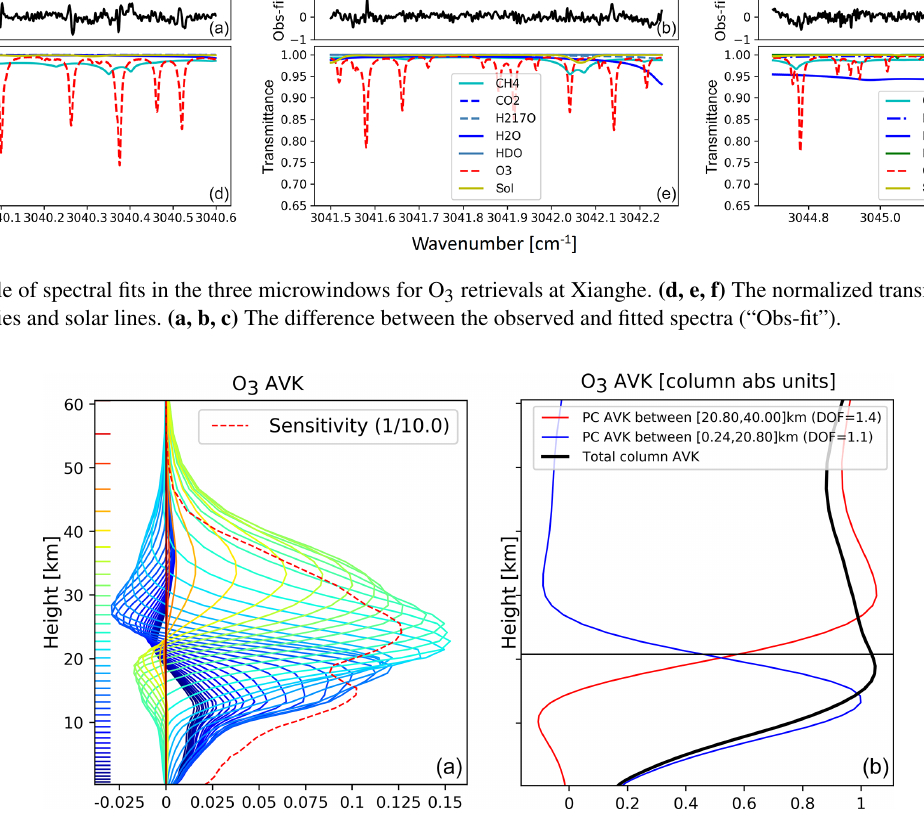
Figure 2. Typical vertical sensitivity of the O 3 retrieval at Xianghe. (a) The averaging kernel (AVK) matrix whose rows are color coded with the altitude of the retrieval grid (48 layers from the surface to the top of atmosphere). The dashed red line is the sensitivity curve (sum of averaging kernel rows) scaled by 1 / 10 to bring it to the same scale as the averaging kernel. (b) The total column averaging kernel (black) and the partial column (PC) averaging kernels of two individual layers (surface–20km and 20–40km) with DOFS equal to 1.1 and 1.4,